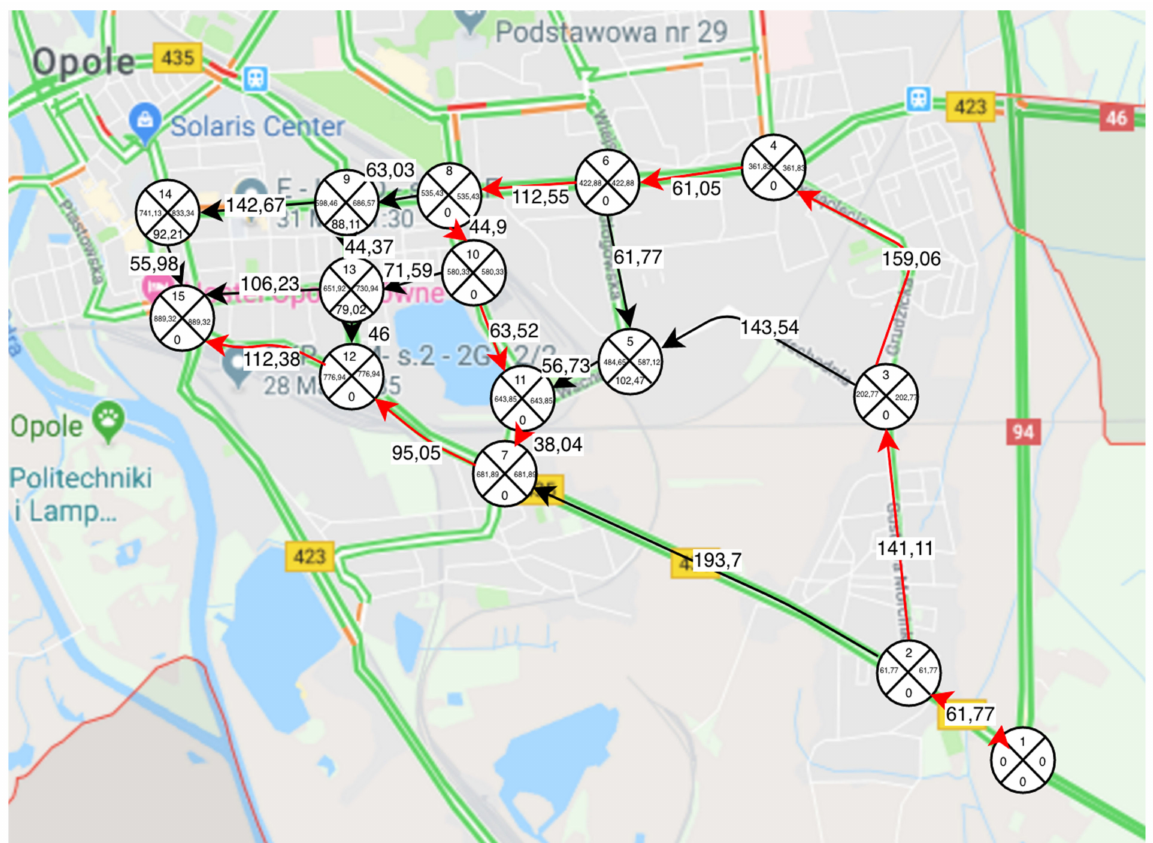
Figure 7. Stage 5—Allocation of average travel time to road sections and stage 6—Making a critical path as a bus line route (red